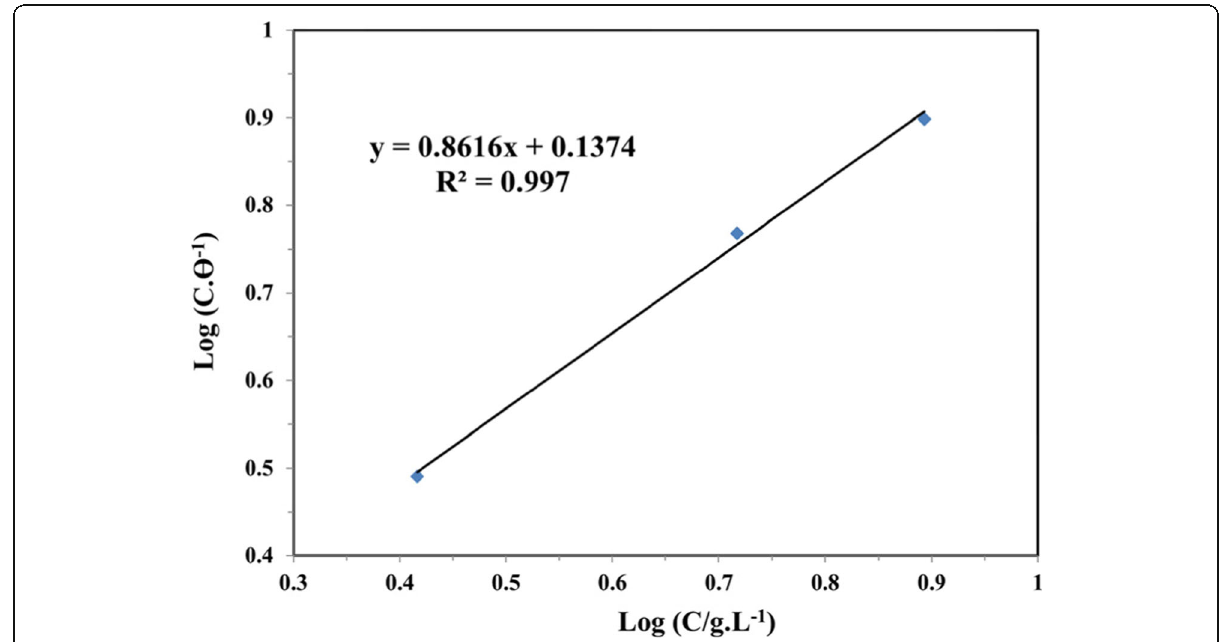
Fig. 10 The isotherm for adsorption isotherm of APE (C, in g/L, dry mass per volume of corresponding